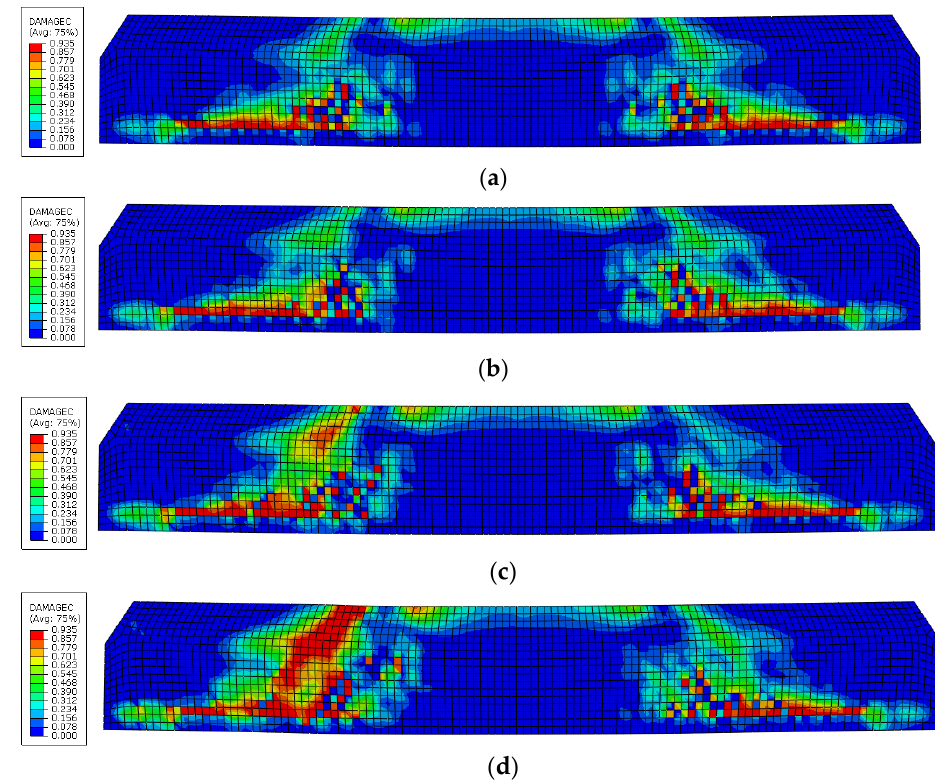
Figure 9. Compressive damage and cracking of concrete in test beams. ( a ) B1 beam; ( b ) B2 beam; ( c ) B3 beam; ( d ) B4 beam.